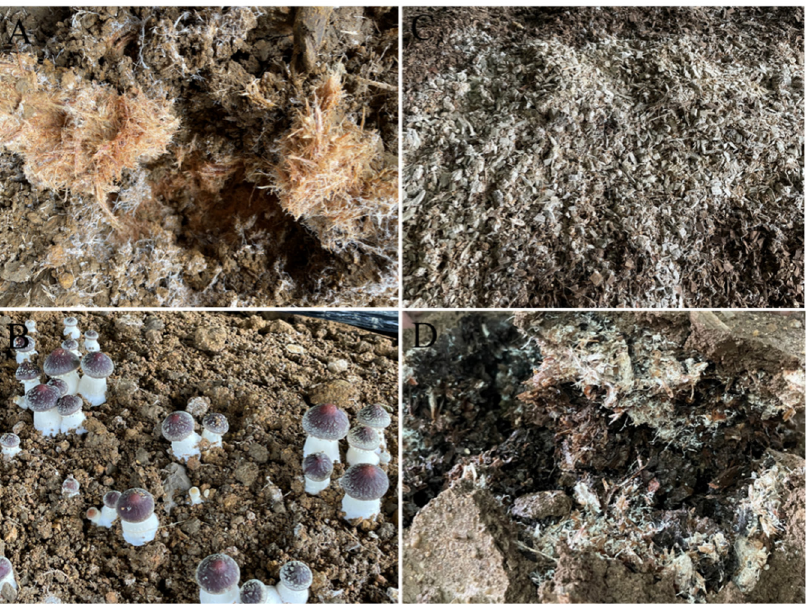
Figure 7. The mycelia and fruiting body of Stropharia rugosoannulata growing on bagasse fiber and sawdust. ( A , B ) The 100% bagasse fiber as substrate to cultivate S. rugosoannulata ; ( C , D ) S. rugosoannulata mycelia growing on 100% sawdust.